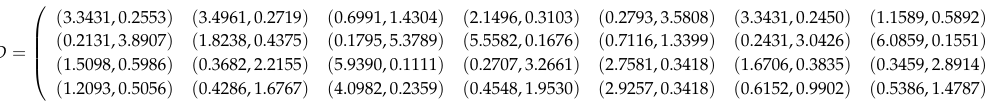
Table 5. The score values s ( α j